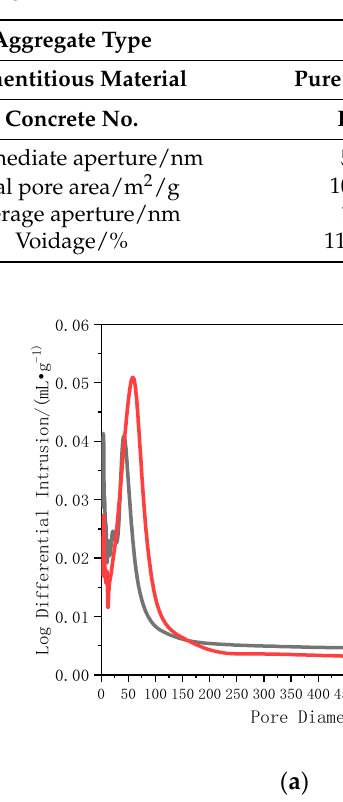
Table 5. Test results for the ITZ pore size in concrete prepared with RM–YPS–cement and pure cement after 28 days of curing.